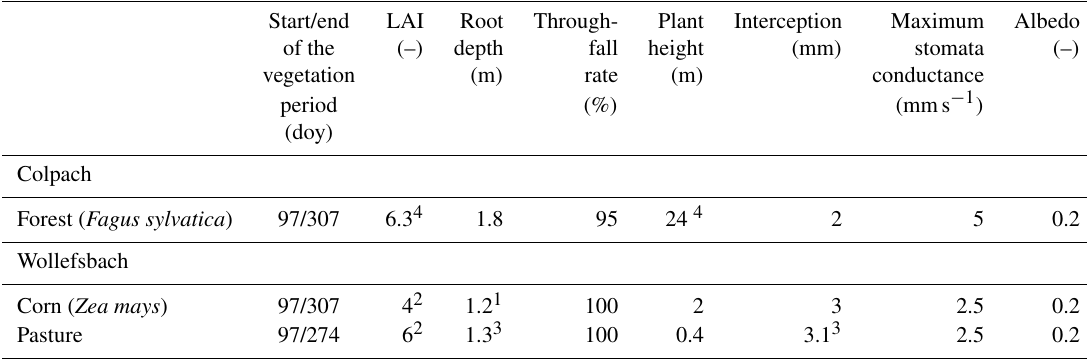
Table 2. Vegetation parameter values for the different land use forms in the model setup. Start/end LAI Root Through- Plant Interception Maximum Albedo of the ( – ) depth fall height ( mm ) stomata ( – ) vegetation ( m ) rate ( m ) conductance period ( % ) ( mms − 1 ) ( doy